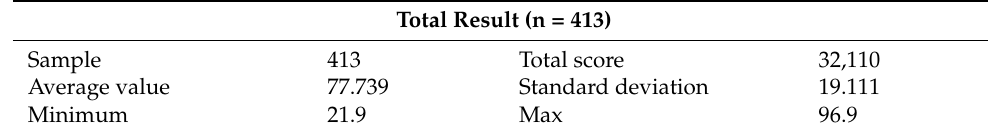
Table 6. System Usability Scale results.